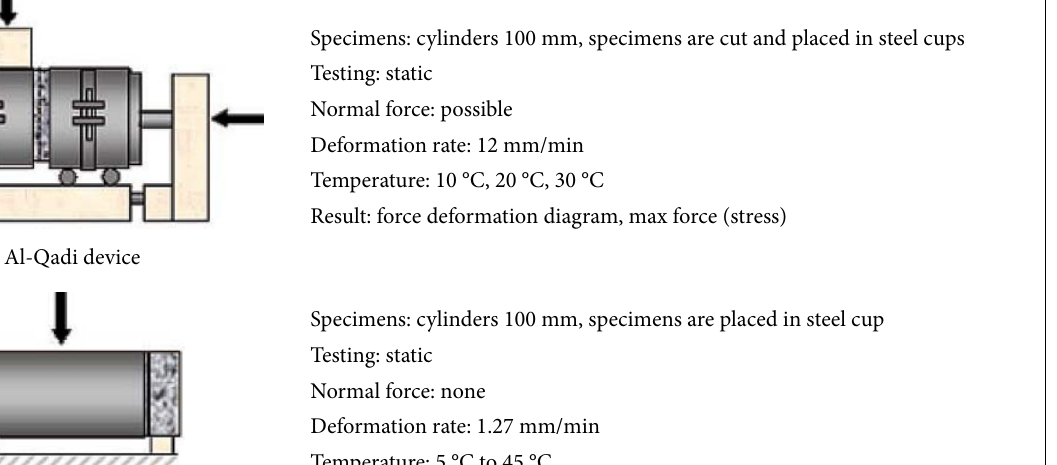
Table 2. Direct shear test devices (2)